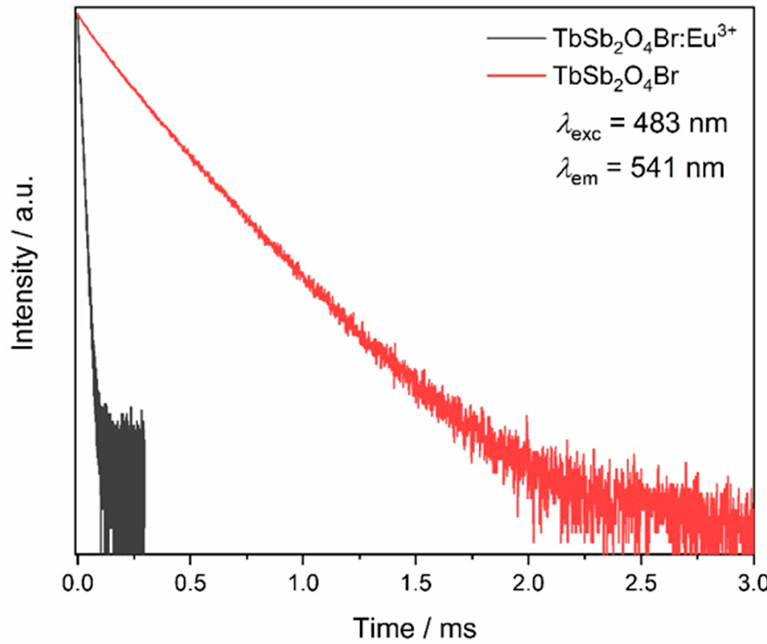
Figure 16. Lifetimes of terbium based compounds. The Tb 3 + emission at λ em = 541 nm is monitored upon excitation at λ exc = 483 nm for both the Eu 3 + -doped and the undoped TbSb 2 O 4 Br samples.